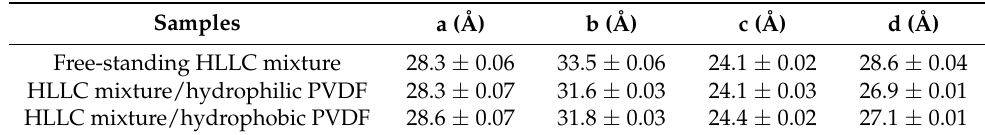
Table 1. Dimensional evolution of structure for d 100 (a) before and (b) after polymerization and column diameter (c) before and (d) after polymerization.